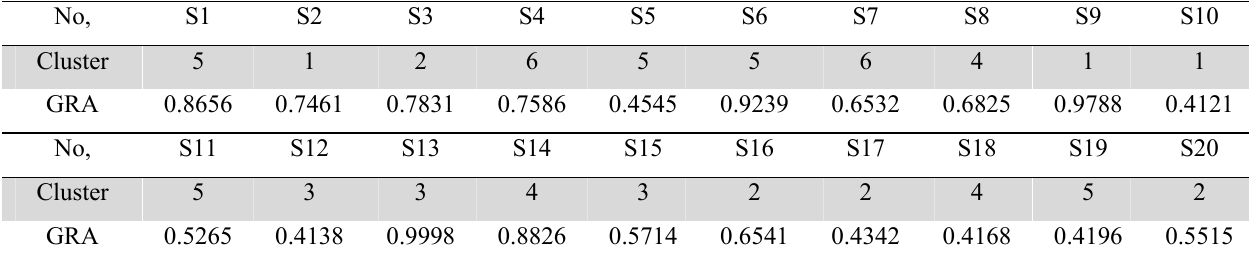
Fig. 3. Results of Suppliers hierarchical clustering Fig. 4. Pareto model solutions by Artificial Bee Colony Ranking results of each cluster by gray relation analysis